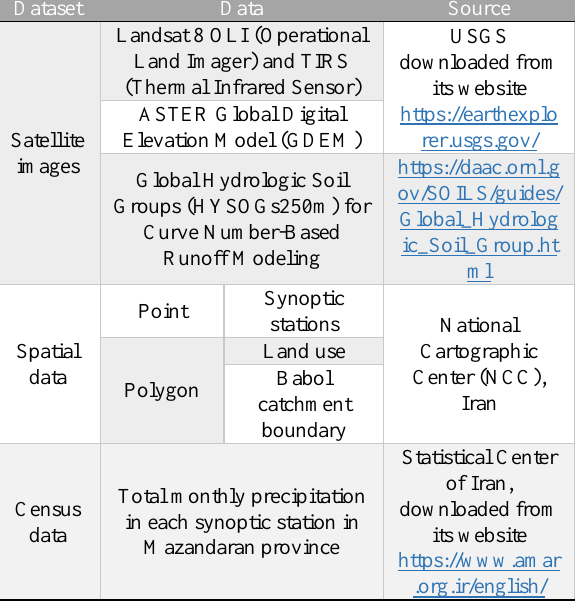
Table 1. The data set used in this research.